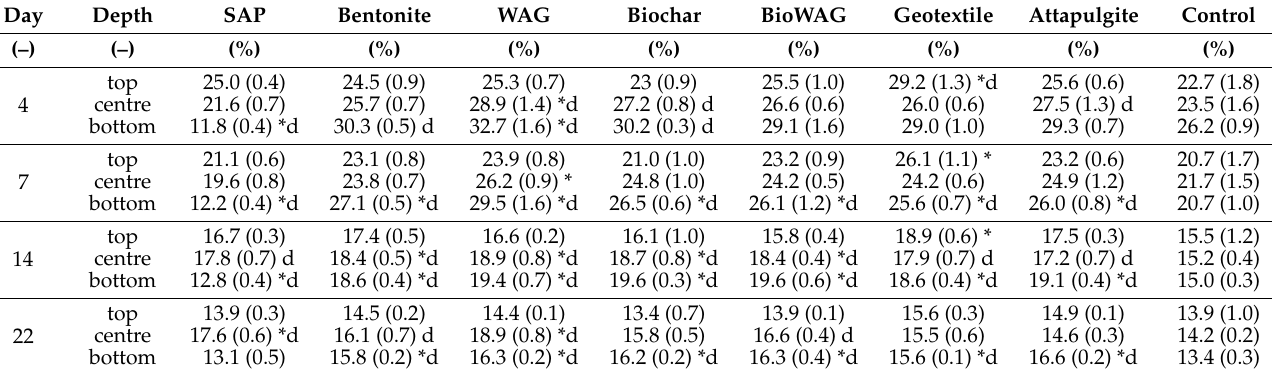
Table 3. Mean soil moisture values in analysed drying